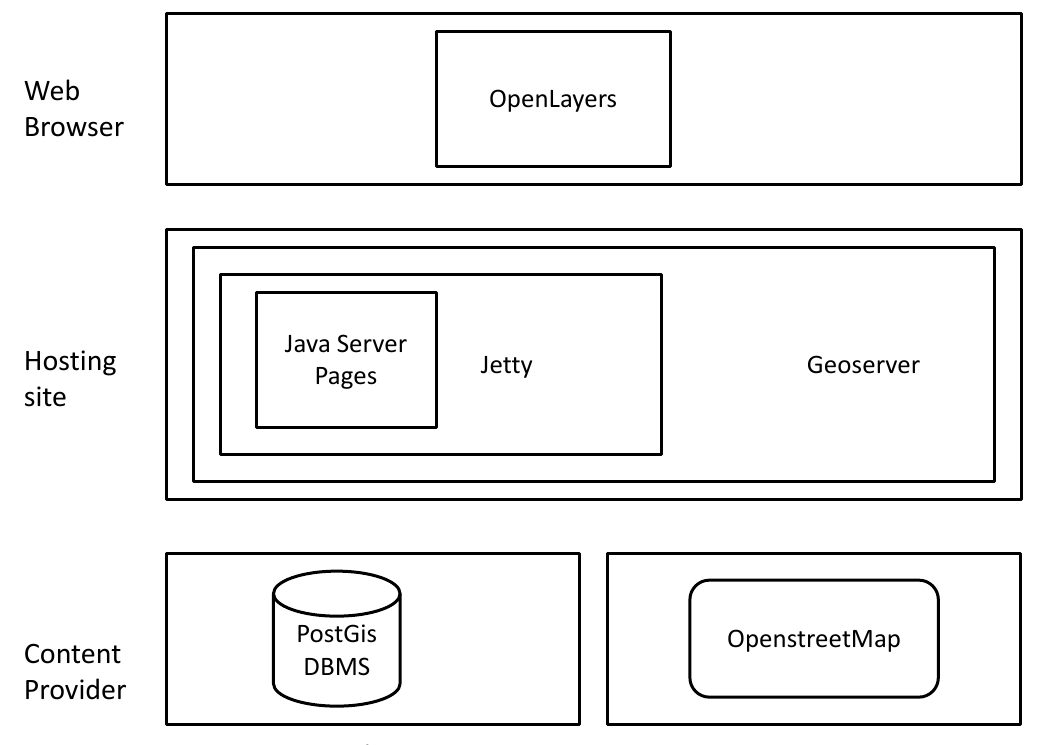
Figure 11. The mash-up software architecture for the SMAT- F1 Second Level